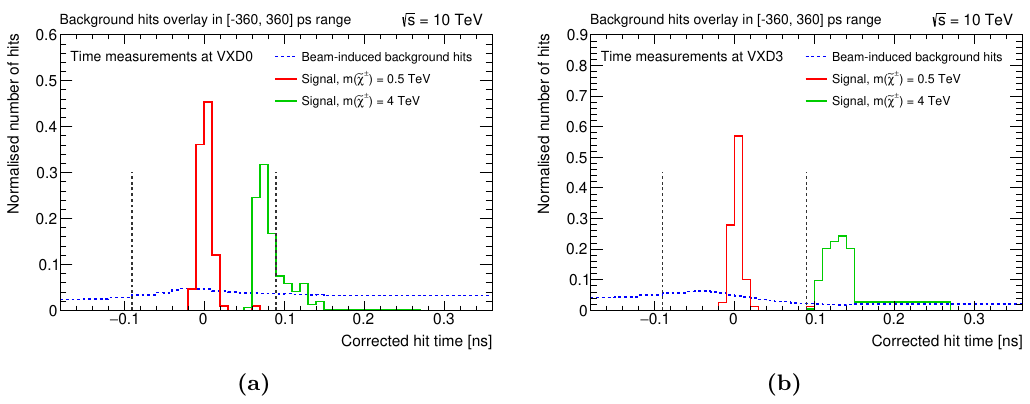
Figure 5. Distribution of the measured detector hit times in the first layer, VXD0 (a), and the fourth layer, VXD3 (b), of the vertex detector corrected by the time of flight that a particle moving at the speed of light would need to reach the hit position if originating from the centre of the interaction region. The red and green lines represent different signal masses, for collisions. The dashed blue line represents the distribution of the arrival time for hits from the BIB. The vertical dashed gray lines indicate the accepted time window for the nominal time selection